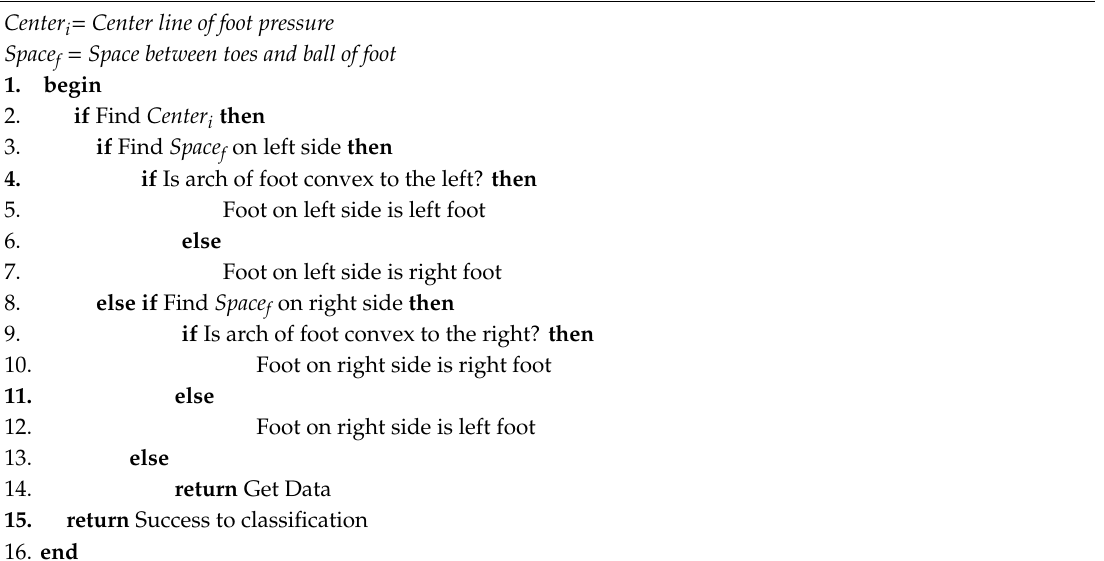
Algorithm 2. Pseudo code for separation and classification of foot